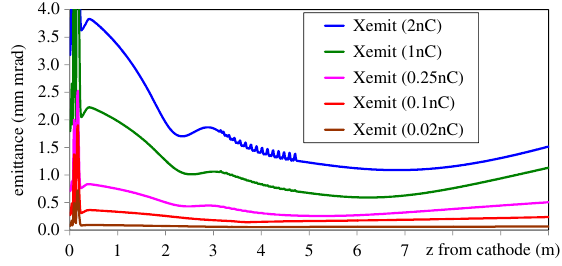
FIG. 7. Normalized transverse projected emittance along the PITZ beam line for various bunch charges. Optimum photo- injector setups from Table I were used.